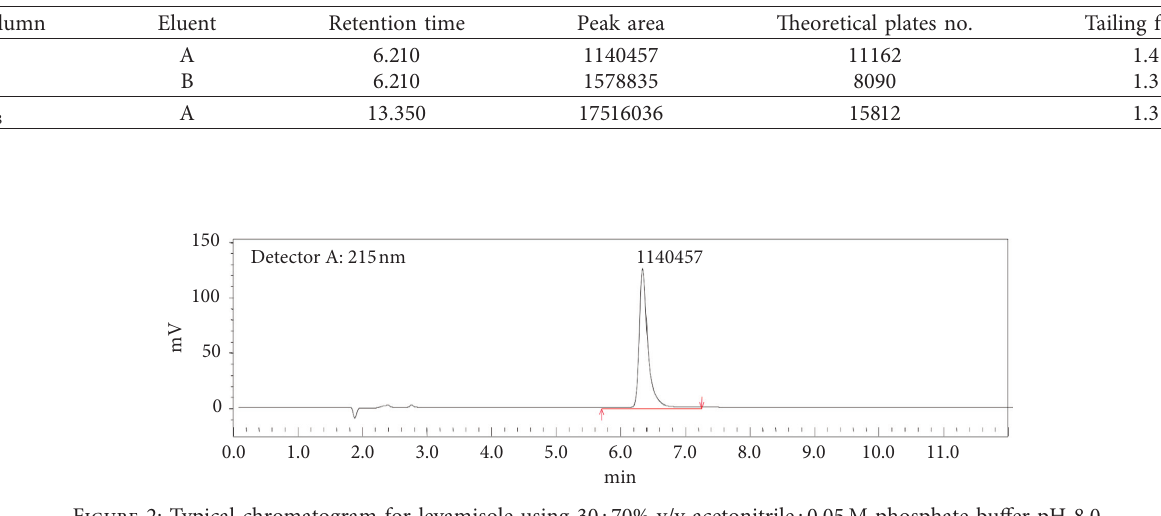
Table 1: System suitability parameters.